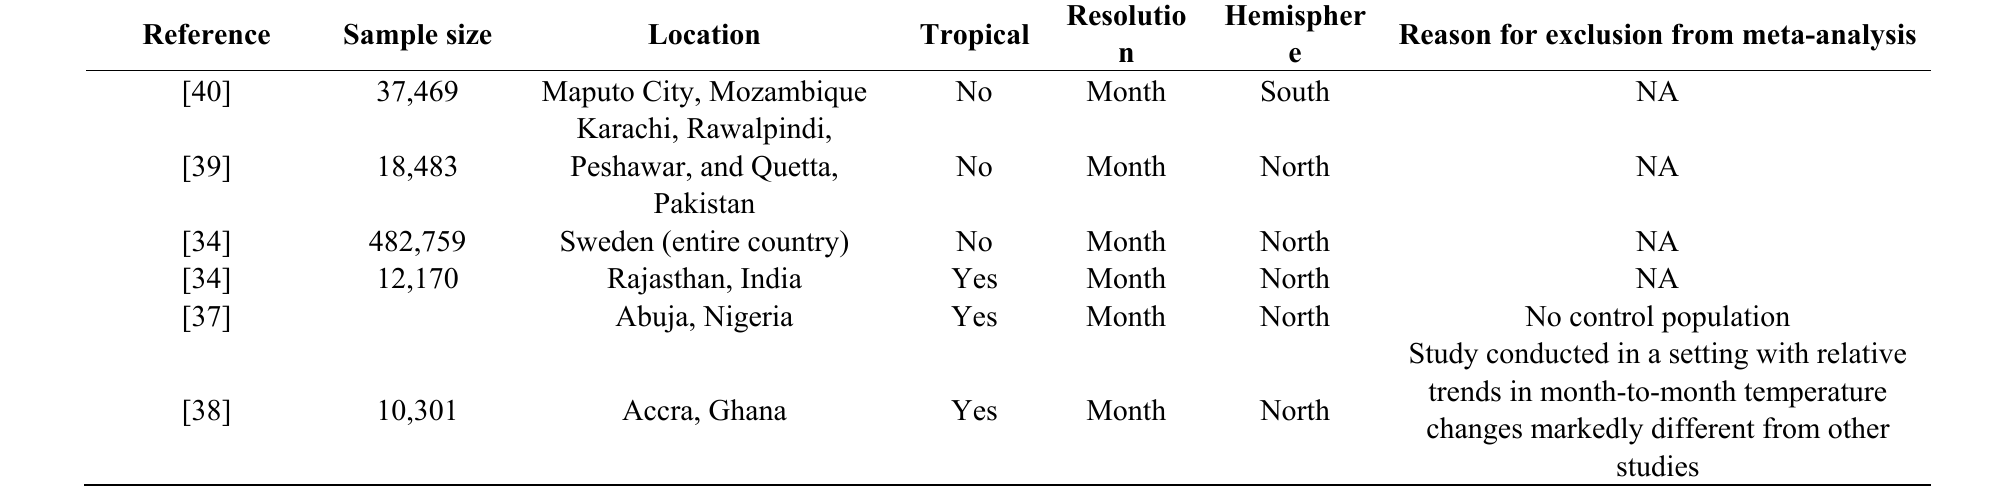
Table A9. Studies examined for the meta analysis of the influence of month of birth on eclampsia incidence.